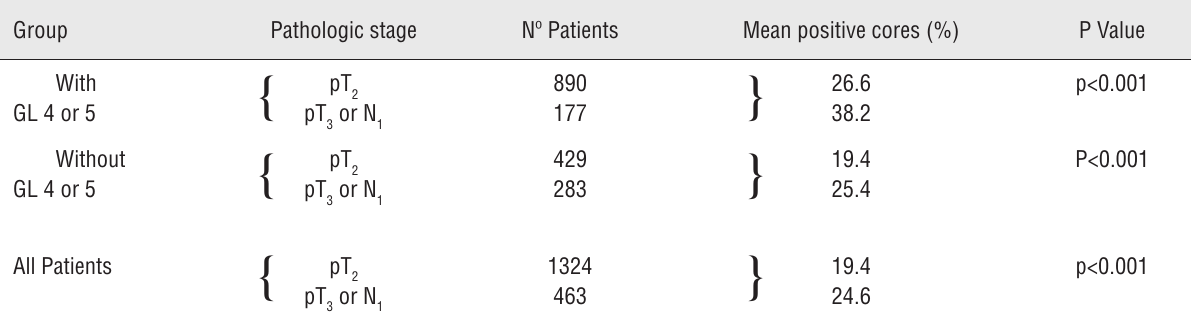
Table 2 - Correlation between the percentage of positive biopsy cores and the pathologic stage in patients with and without grade 4 or 5 component in biopsy Gleason